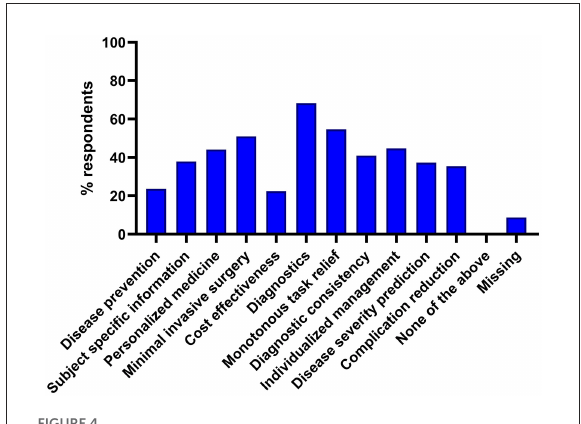
FIGURE4 Perceived advantages of the use of artificial intelligence in medicine. Responses were selected from a list of set choices, multiple selections were possible. FIGURE5